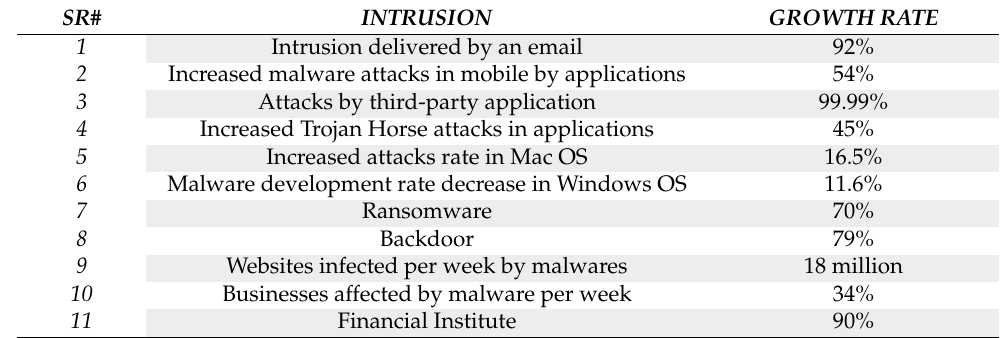
Table 1. Growth rate of malware attacks.